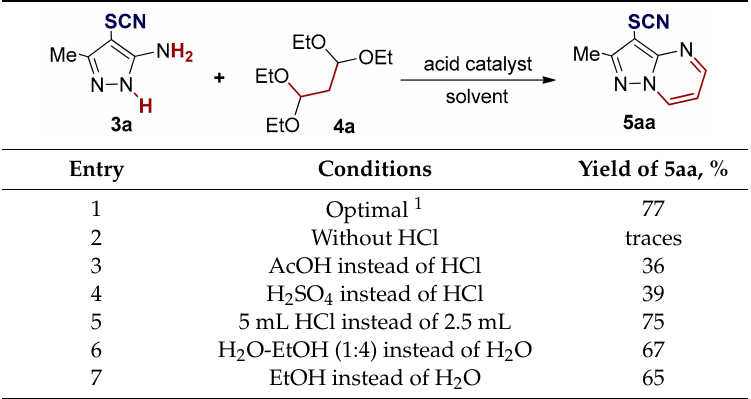
Entry Conditions Yield of 5aa, % Optimal